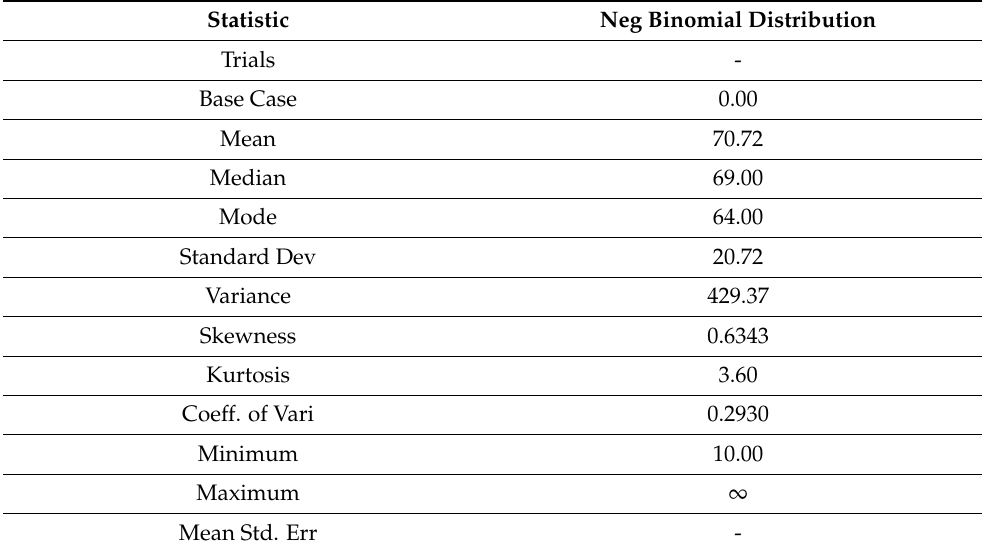
Table 6. Descriptive statistics of the probability distribution for rent prices of a standard double-room in Košice.